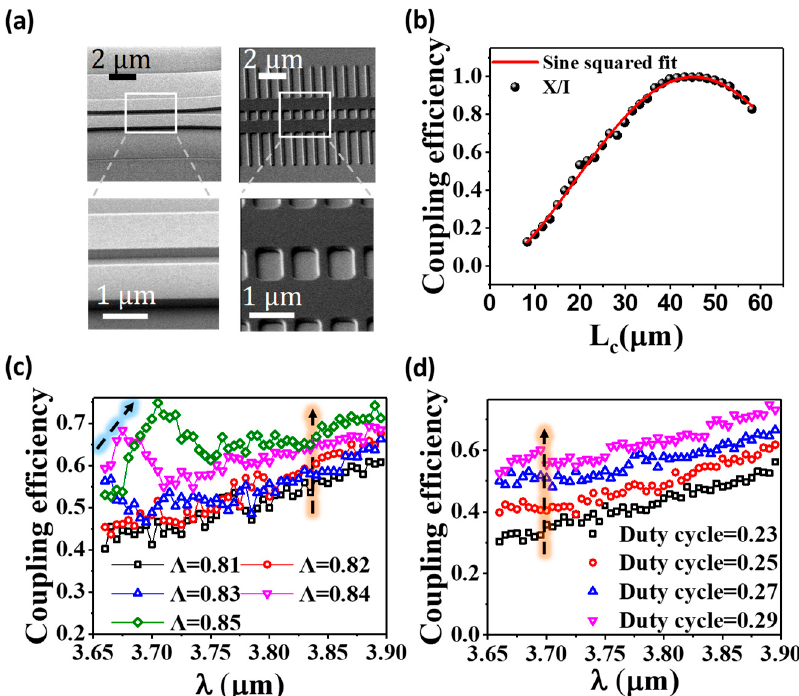
Figure 4. ( a ) The scanning electron microscope (SEM) images of conventional DC and SWG-based WFDC. ( b ) The DC behavior of the SWG-based WFDC with Λ = 0.83 µm and duty cycle = 0.25 at 3.7 µm. The data fits well with the sine squared function with adj. R-square of 0.997, showing good performance of the SWG-based WFDC. ( c ) The influence of Λ on coupling efficiency. Duty cycle and the number of SWG periods are fixed at 0.25 and 30 respectively. ( d ) The influence of duty cycle on coupling efficiency. Λ and the number of SWG periods are fixed at 0.81 µm and 30 respectively.